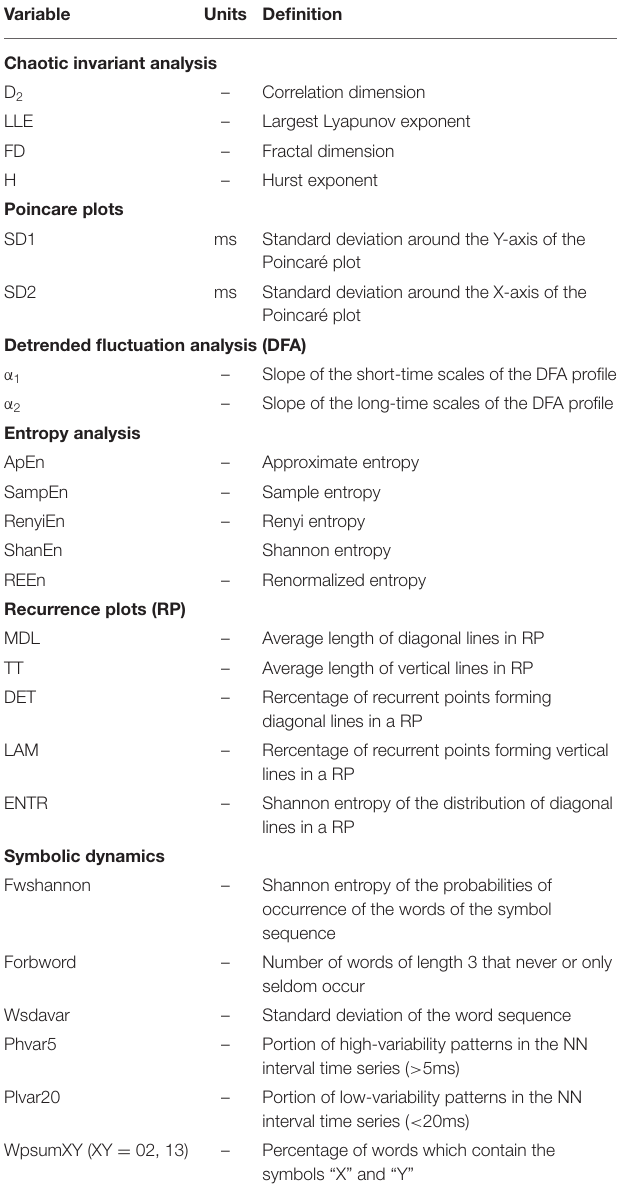
TABLE 3 | Selected non-linear HRV parameters and methods.